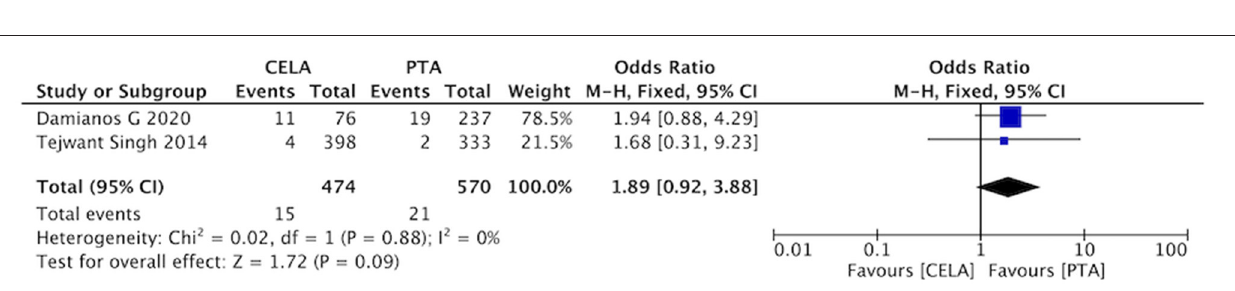
FIGURE 8 | Forest plot for bailout stenting. Fixed, a fixed effects model; CI, confidence intervals. The blue squares stand for the weight of studies in meta-analysis. Black rhomboid represents the effects of combination of above two studies.